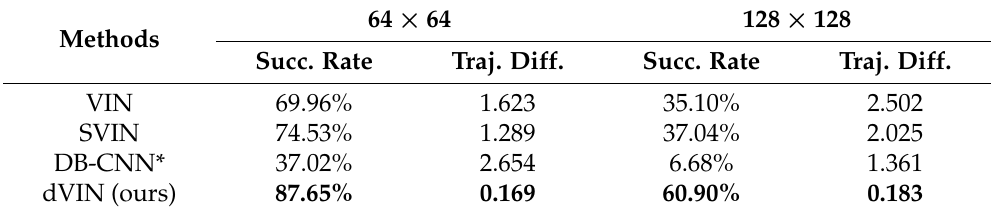
Table 2. Performance on 64 28 28 domains and directly tested in large-size ×